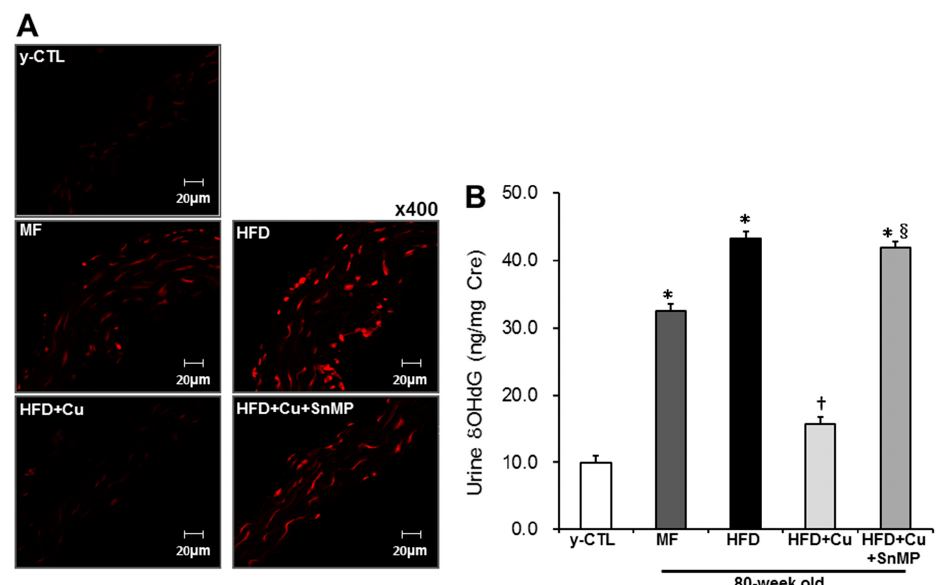
Figure 3. Effect of curcumin on oxidative stress in mice. MF (standard feed), High-fat diet (HFD), 0.1% curcumin-mixed HFD (HFD + Cu), or 0.1% curcumin-mixed HFD plus SnMP (HFD + Cu + SnMP) was